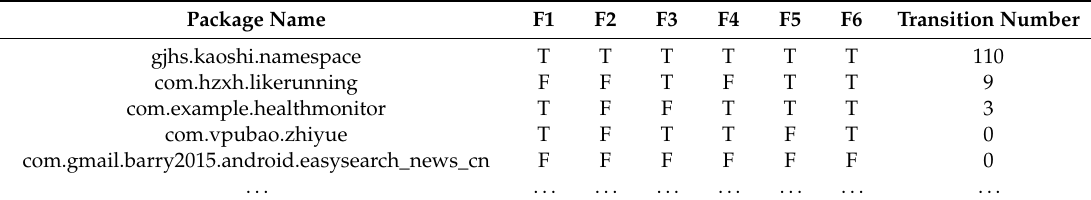
Table 10. Part of the feature set extraction.